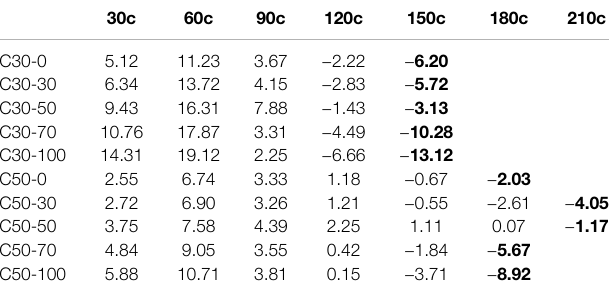
TABLE 7 | Relative mass factor of concrete after sulfate wetting – drying cycles.